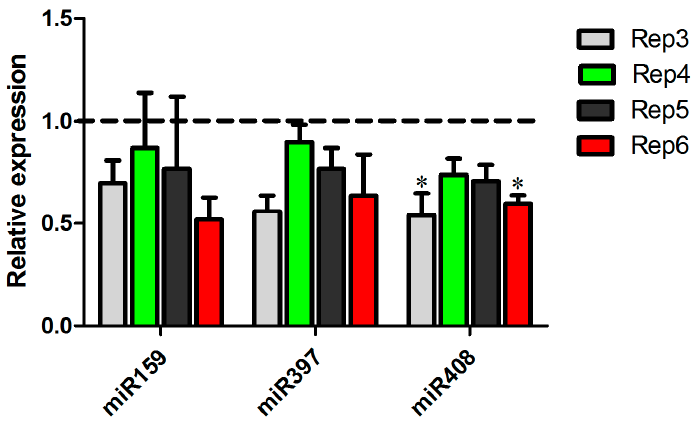
Figure 6. Validation of miRNA expression in the other four experiments. The expression of miR159, miR397, and miR408 was tested in mock-inoculated plants and Acidovorax avenae -infected plants by real-time PCR. Dotted line represents the expression of the control samples. The error bars represent the standard deviation between three technical replicates. * represents significant changes of target expression between the control and inoculated samples ( p -value < 0.05).